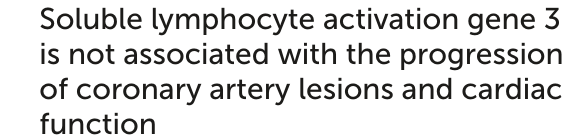
adjusting for hypertension and BMI, the sLAG3 was inversely associated with CAD (OR = 0.221, P < 0.05). Additionally, after